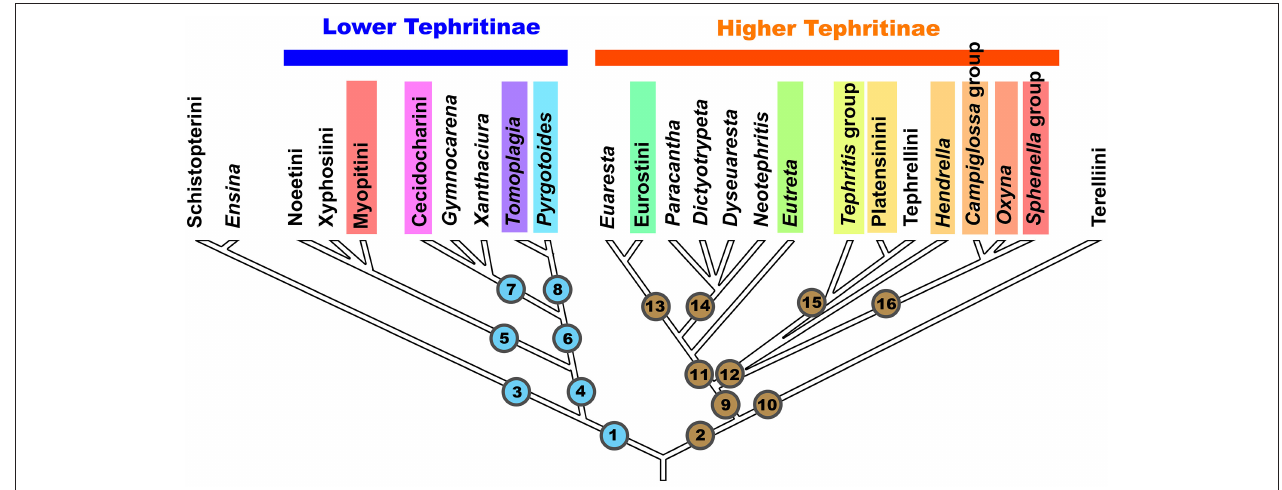
FIGURE 1 | Scheme of phylogenetic relationships among the tribes, groups of genera, and genera of the subfamily Tephritinae (based on Han et al., 2006). Color bars mark the taxa, which include gall-inducing